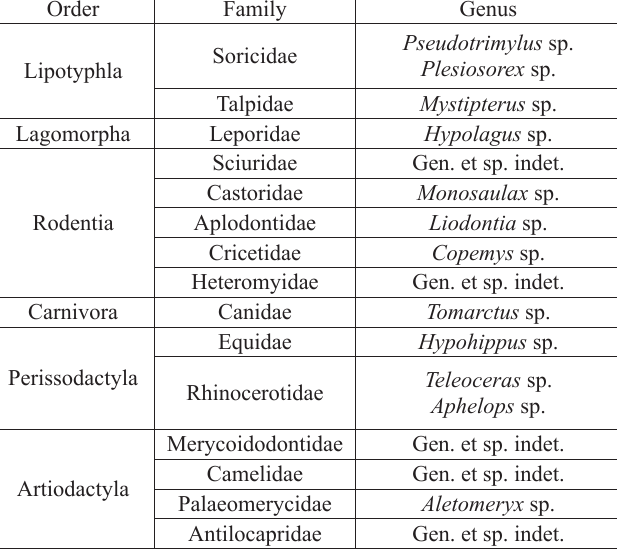
Table 1. List of mammals identified by Donald E. Savage from the “Ne- vaxel locality” (UCMP V70138), constituting the original Eastgate LF (from Axelrod 1985; taxonomy updated), Eastgate, Churchill County, Nevada, USA; Monarch Mill Formation, Barstovian